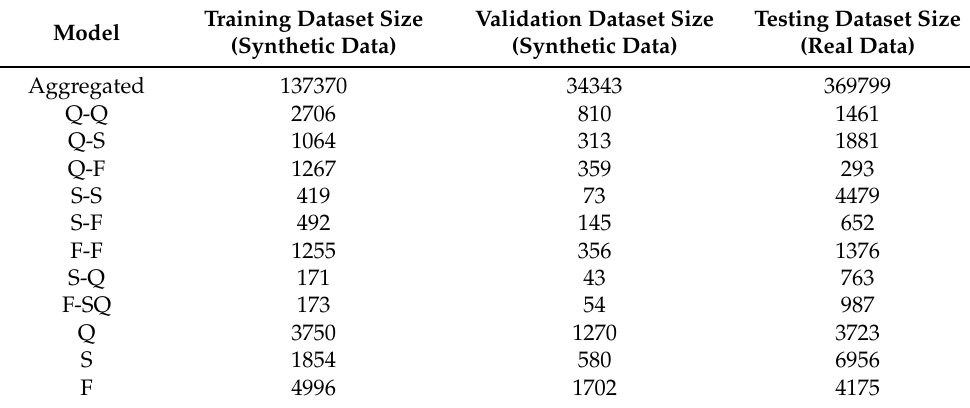
Table 6. Training, validation, and testing datasets size for each